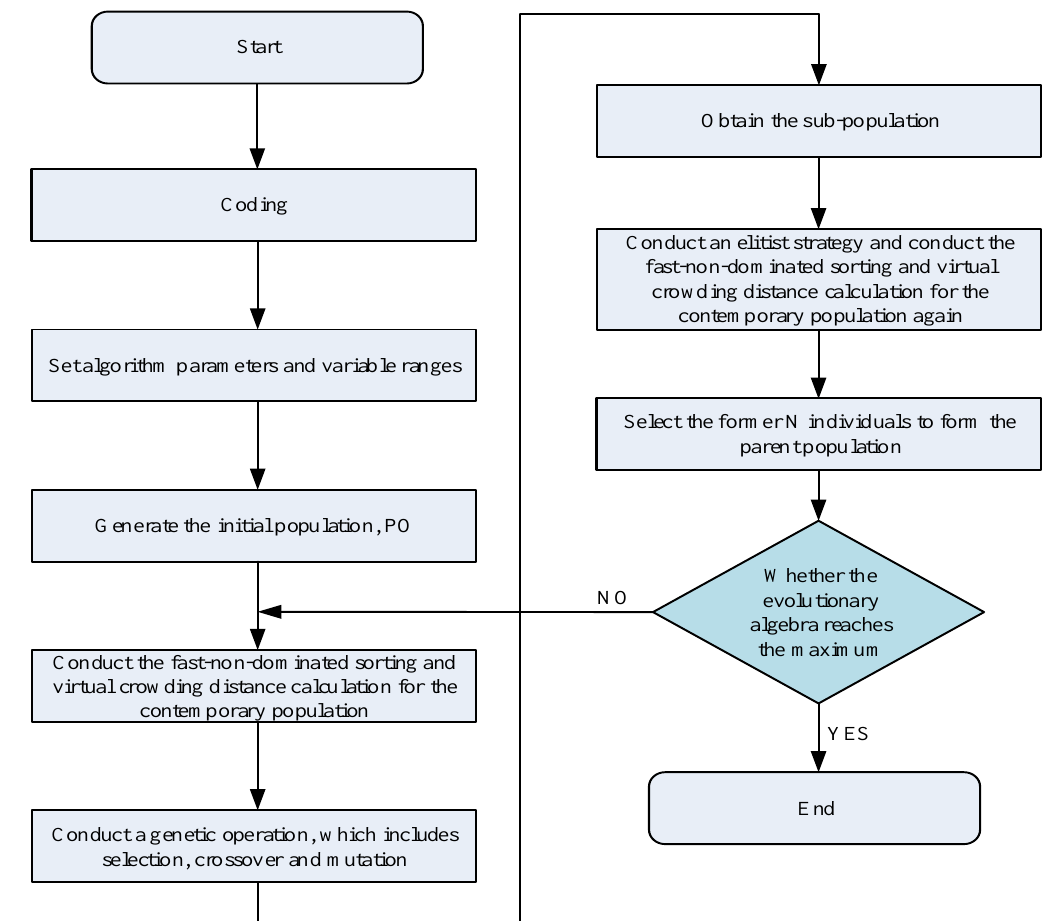
Figure 2. The specific process of the NSGA-II (Non-dominated Sorting Genetic Algorithm-II) algorithm.